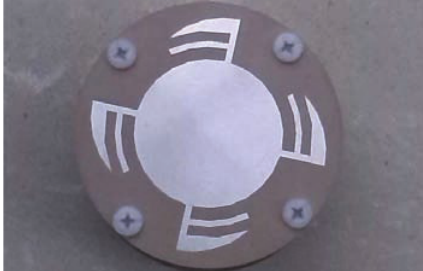
Figure 5: Photograph of the proposed